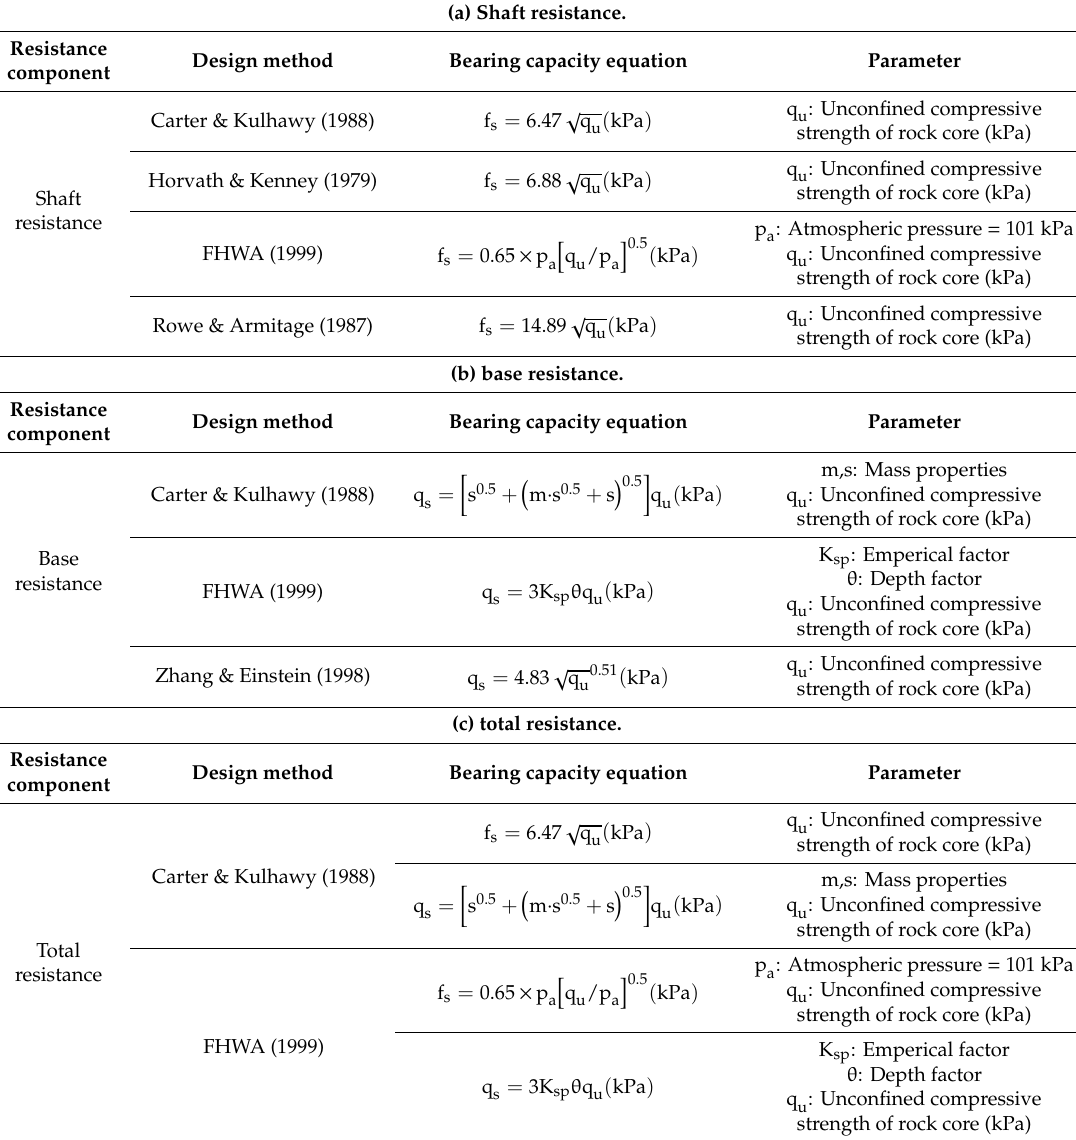
Table 4. Bearing capacity equations for the predicted